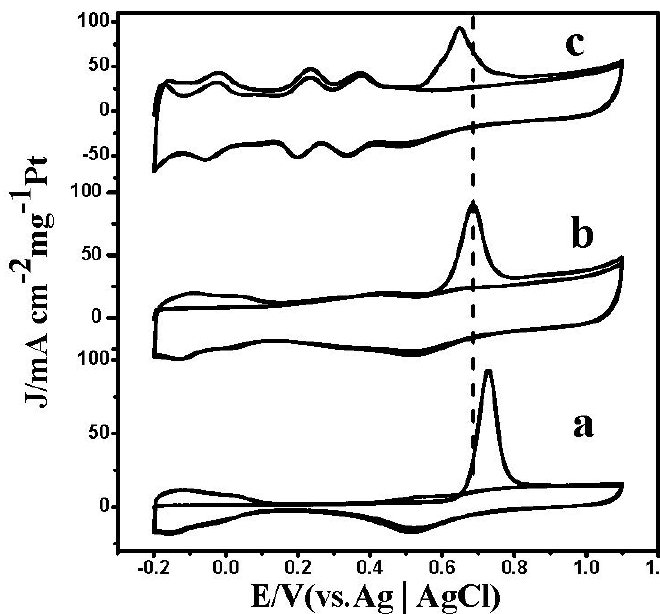
Figure 10. CO-stripping curves of different modified electrodes: ( a ) Pt/GCE; ( b ) Pt/rGO/GCE; ( c ) PMo 12 -Pt/rGO/GCE in 0.5 M H 2 SO 4 solution. Scan rate: 100 mV·s − 1